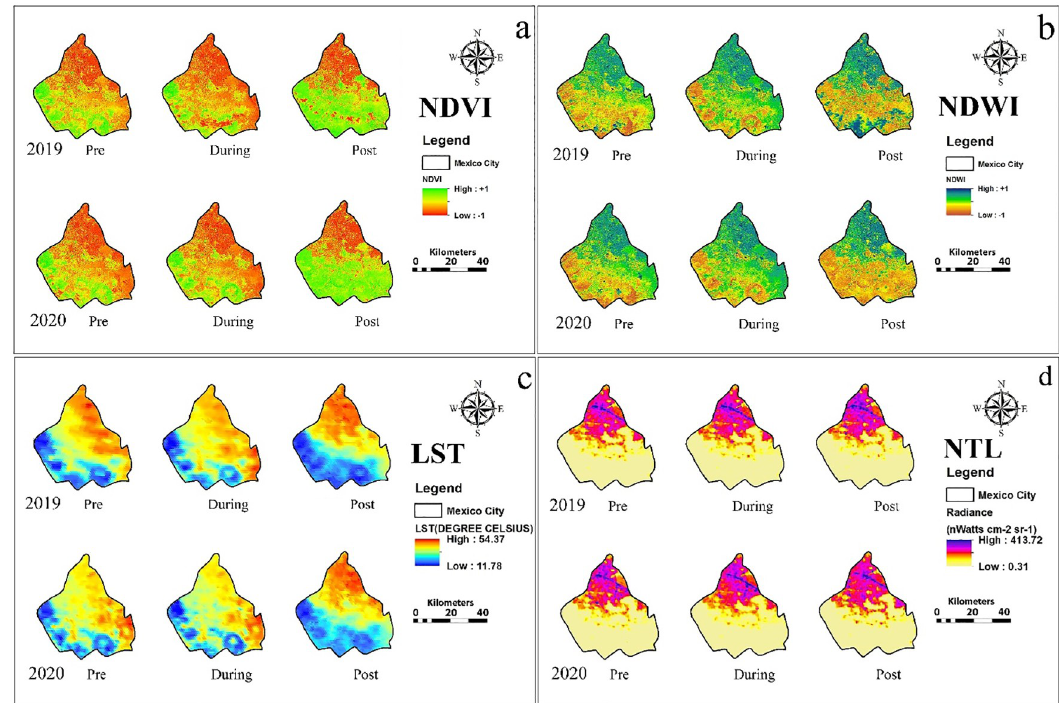
Fig 2. Spatio-temporal changes in a) NDVI, b) NDWI, c) LST and d) NTL based on the thematic maps of the Mexico city.